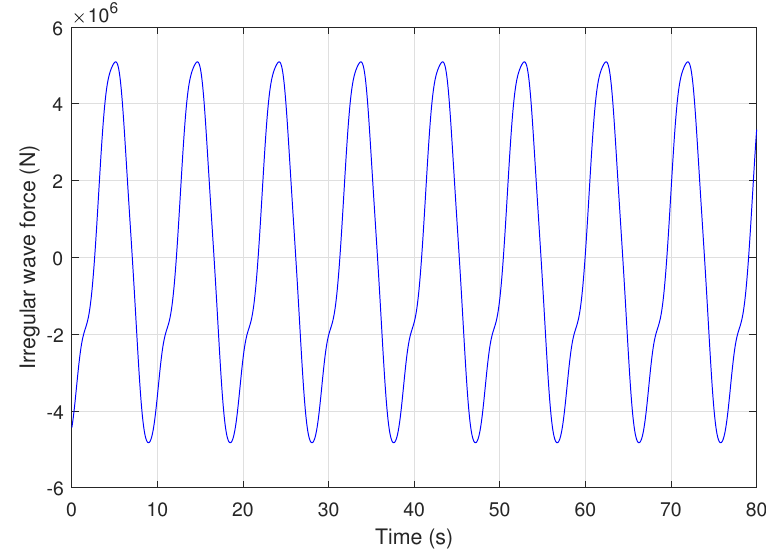
Figure 4. The irregular wave force on the